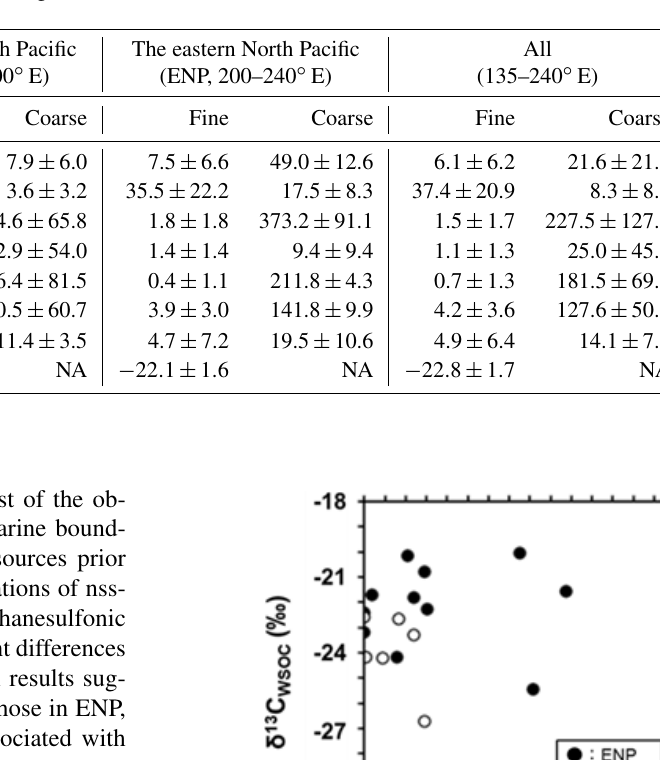
Table 1. Average concentrations of nitrogen species and stable carbon isotope ratios in the fine ( D p < 0 . 95µm) and coarse ( D p > 0 . 95µm) aerosol particles collected along 23 ◦ N in each oceanic region.